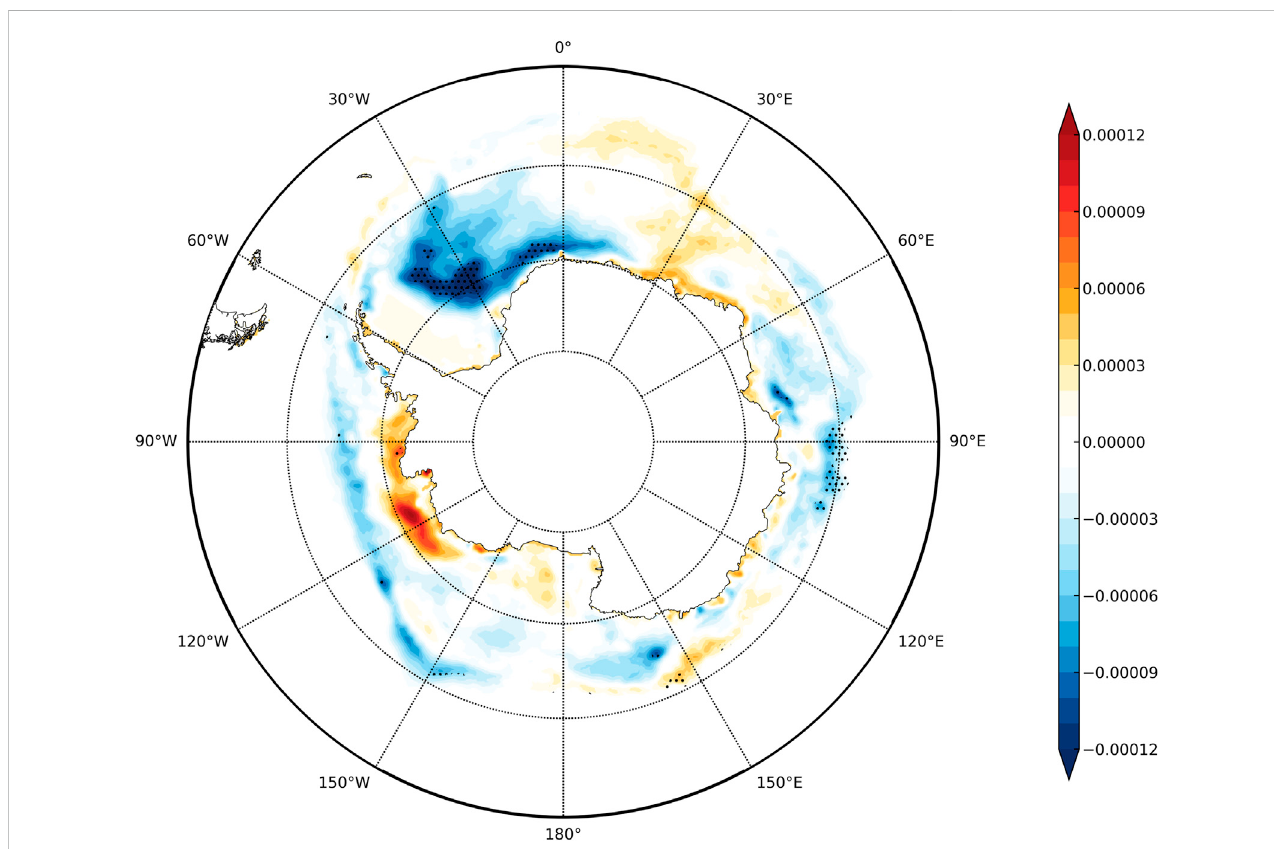
FIGURE 1 Trend of Antarctic SIC during 2014 – 2020 (unit: % per season). The bold dots denote statistically signi fi cant change at 95% con fi dence level.